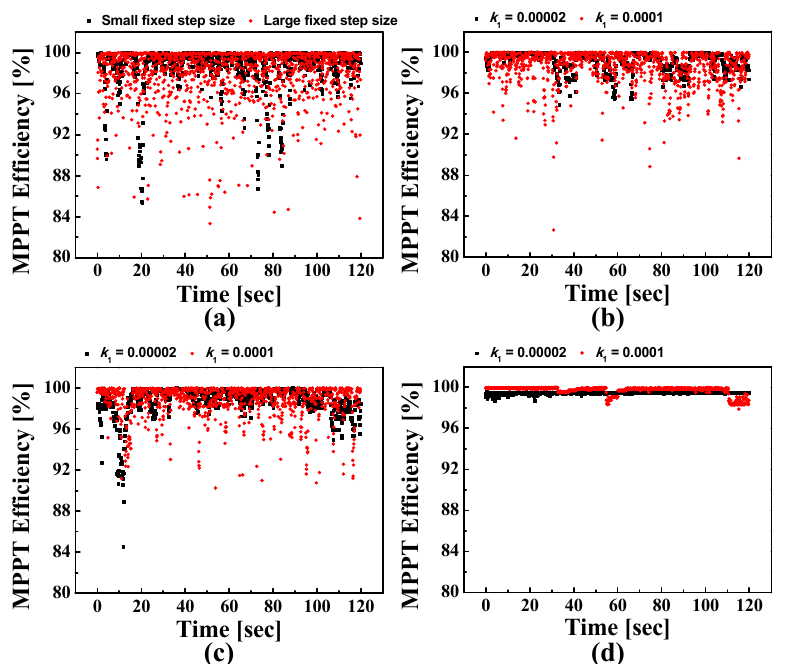
Figure 15. Measured MPPT efficiencies of ( a ) the basic P&O with small or large fixe step sizes, ( b ) the adaptive P&O with low k 1 (=0.00002) or high k 1 (=0.0001), ( c ) the adaptive INC with low k 1 (=0.00002) or high k 1 (=0.0001), and ( d ) the proposed MPPT algorithms with low k 1 (=0.00002) or high k 1 (=0.0001).